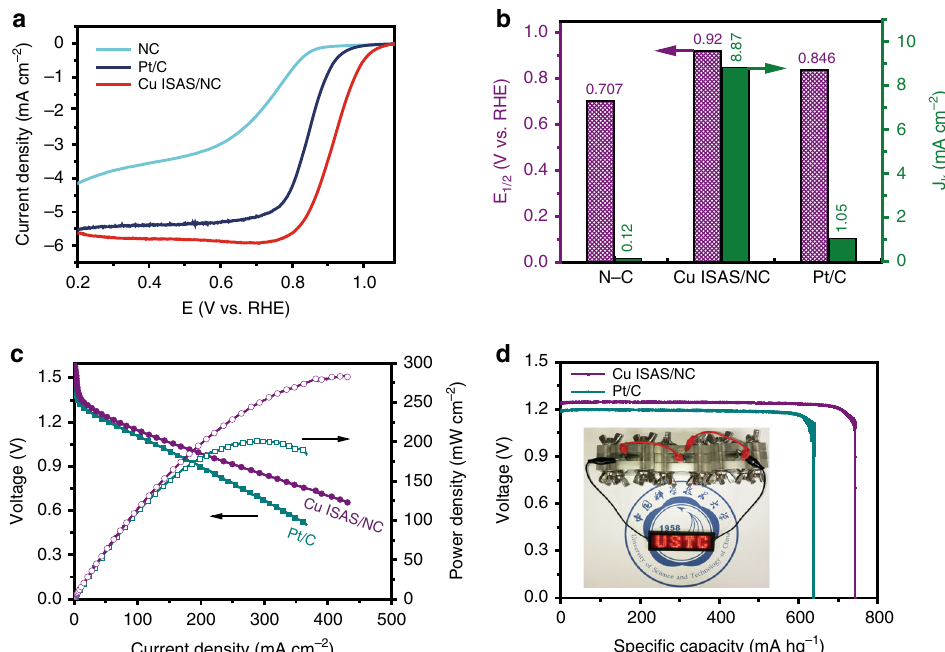
Fig. 2 Electrocatalytic oxygen reduction and Zn-air battery performances. a Linear sweep voltammetry (LSV) curves of NC, Cu ISAS/NC and Pt/C catalysts in 0.1 M KOH solution with a sweep rate of 10 mV s − 1 and rotation rate of 1600 rpm. b half-wave potential ( E 1/2 ) and kinetic current density ( J K ) of different catalysts. c Polarization and corresponding power density plots of Cu ISAS/NC and Pt/C-based Zn-air batteries. d The speci fi c capacity of Cu ISAS/NC and Pt/C-based Zn-air batteries at 50 mA cm − 2 . (Inset: a photograph showing light-emitting diode panel powered by three Cu ISAS/NC-based Zn –